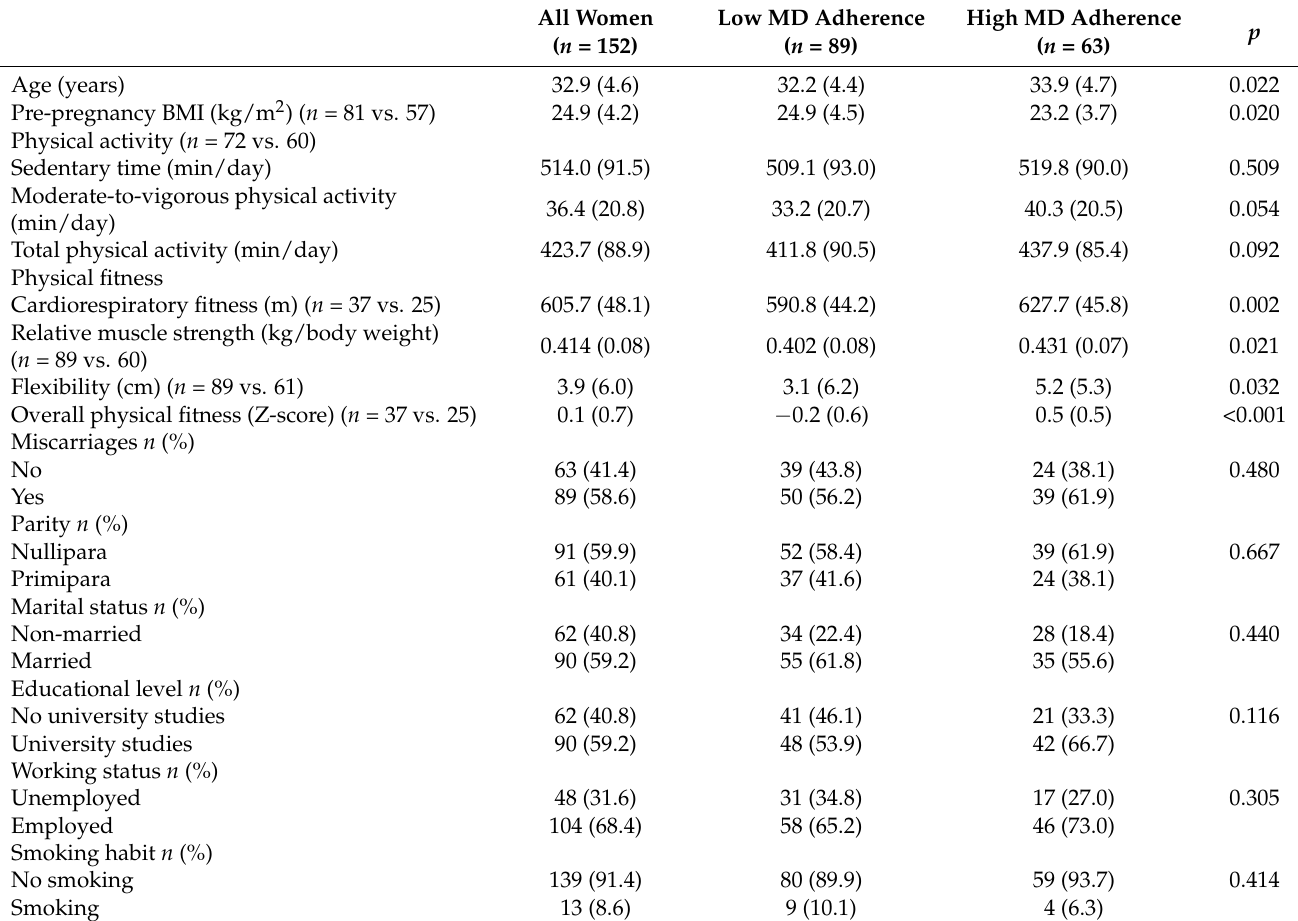
Table 1. Population characteristics by the degree of Mediterranean diet adherence. All Women Low MD ( n = 152)